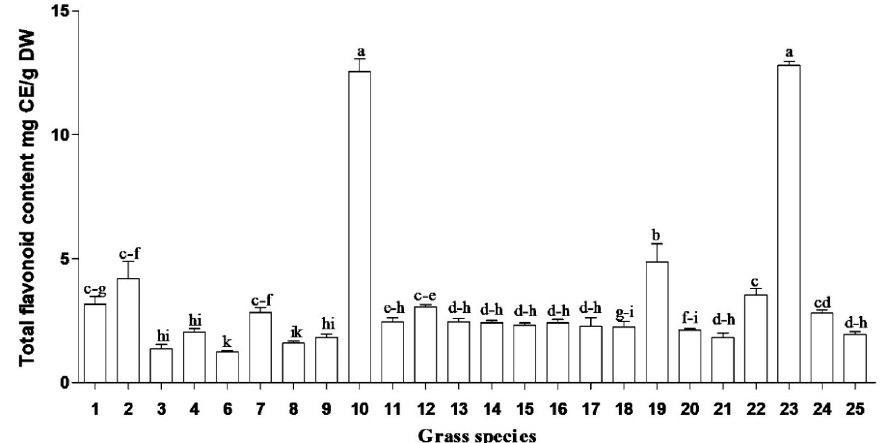
Figure 2. Concentrations of flavonoids in grass species used in traditional South African medicine. CE = Catechin equivalents; DW = dry weight. Bar represents mean ± standard error, n = 3. Bars with different letter(s) are significantly ( p ≤ 0.05) different based on Duncan’s multiple range test (DMRT). (1) Coix lacryma-jobi Roots, (2) Coix lacryma-jobi Leaves, (3) Eragrostis curvula Roots, (4) Eragrostis curvula Leaves, (6) Setaria megaphylla Roots, (7) Setaria megaphylla Leaves, (8) Vetiveria zizanioides Roots, (9) Vetiveria zizanioides Leaves, (10) Cymbopogon nardus Roots, (11) Cymbopogon nardus Leaves, (12) Cymbopogon nardus Inflorescence, (13) Sporobolus pyramidalis Roots, (14) Sporobolus pyramidalis Leaves, (15) Sporobolus africanus Roots, (16) Sporobolus africanus Leaves, (17) Imperata cylindrical Roots, (18) Imperata cylindrical Leaves, (19) Cenchrus ciliaris Roots, (20) Cenchrus ciliaris Leaves, (21) Panicum maximum Roots, (22) Panicum maximum Leaves, (23) Cymbopogon spp. Roots, (24) Cymbopogon spp. Leaves and (25) Cynodon dactylon Whole plant.